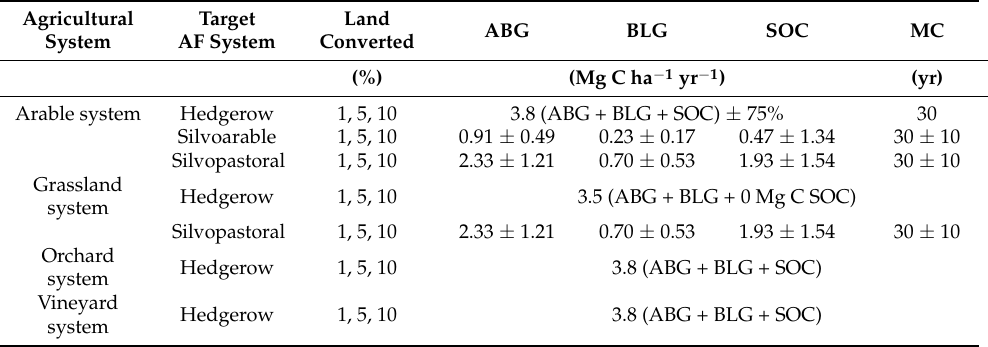
Table A2. The IPCC Tier 1 carbon sequestration rates for above-ground (ABG) and below-ground (BLG) biomass and soil organic carbon (SOC) in the upper (0–30 cm) soil layer for different agro- forestry systems. Confidence intervals for hedgerows derived by applying the IPCC guidance that assumes an error of 75% when information is not available. MC—length of maturity